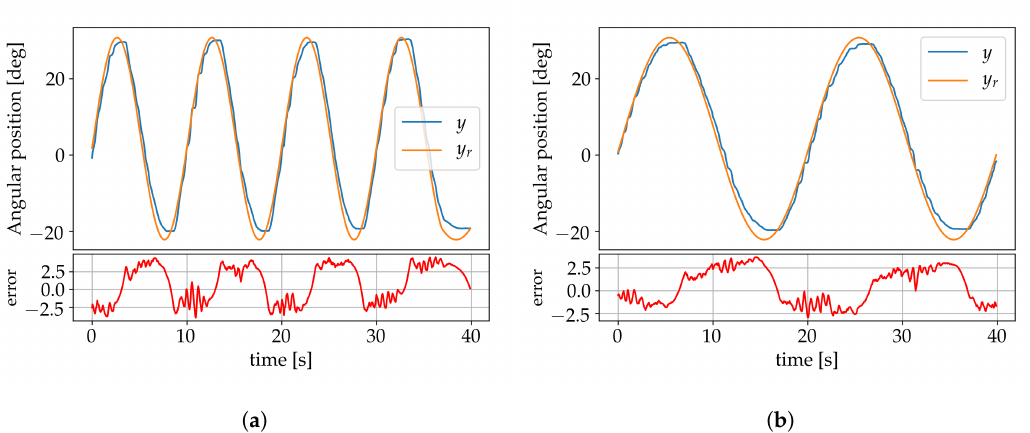
Figure 16. ( a ) Results for a 0.01 Hz sine wave; ( b ) Results for a 0.005 Hz sine wave.